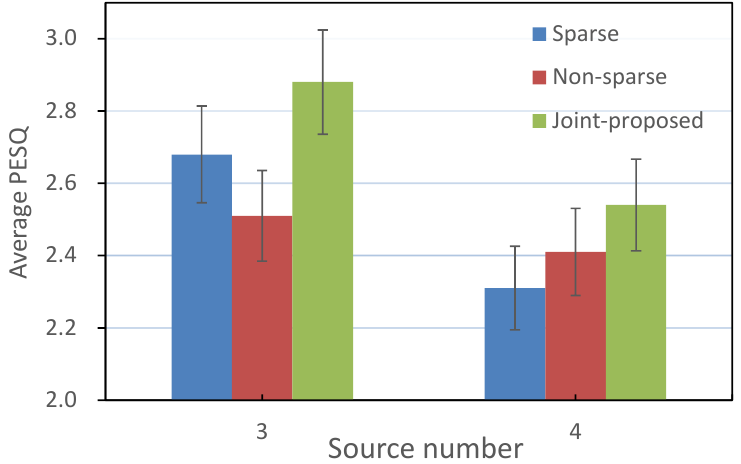
Figure 8. Average PESQ of the separated signals from sparse component points, non-sparse component points and the whole TF points.